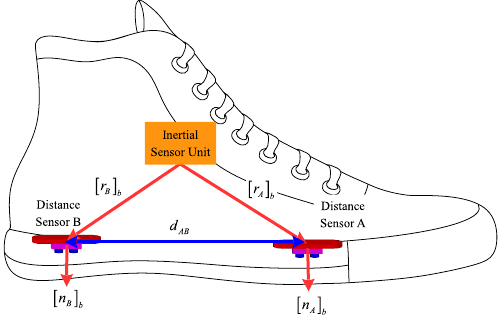
Figure 1. Inertial and distance sensors on a